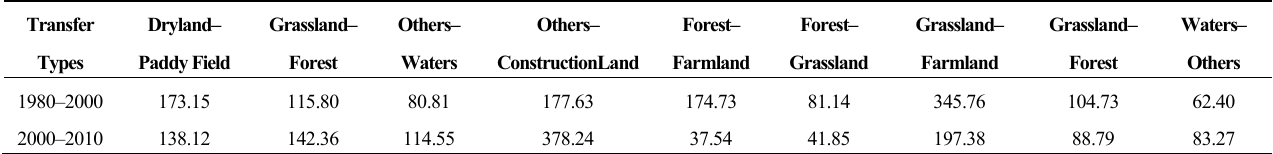
Table 5. Area of land use conversion in China during the two periods of 1980s–2000 and 2000–2010.